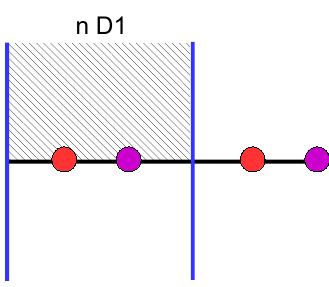
Figure 23 . Setup with n superposed D1 strings, leading to the relation v n